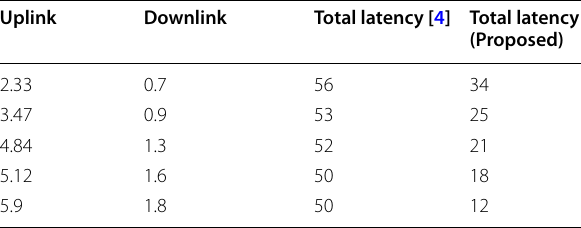
Table 1 Latency using synchronization